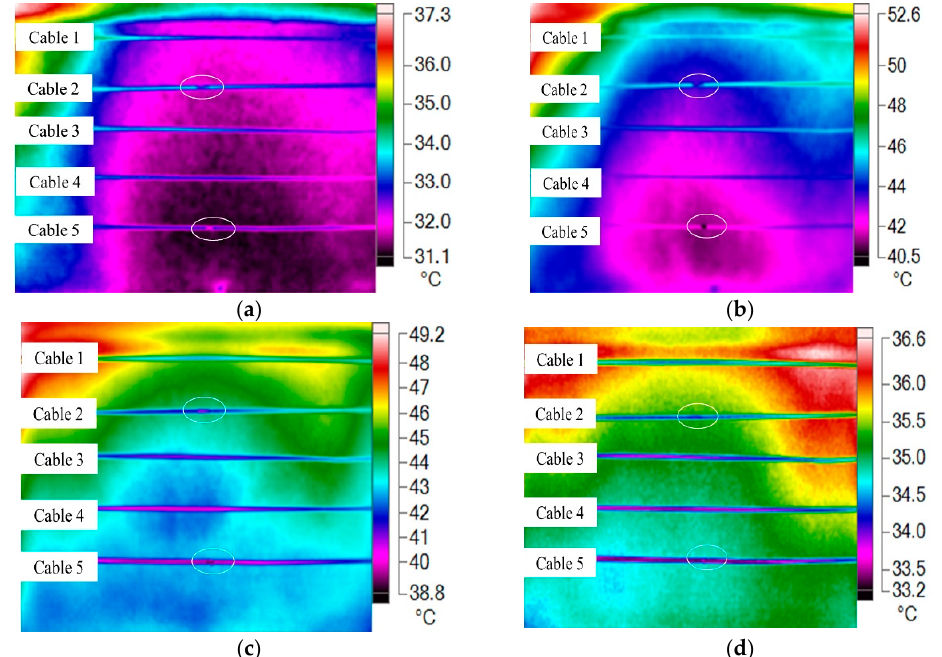
Figure 5. Surface temperature distribution of the Group #1 cables. ( a ) Heating up for 10 s. ( b ) Heating up for 80 s. ( c ) Cooling off for 20 s. ( d ) Cooling off for 80 s.